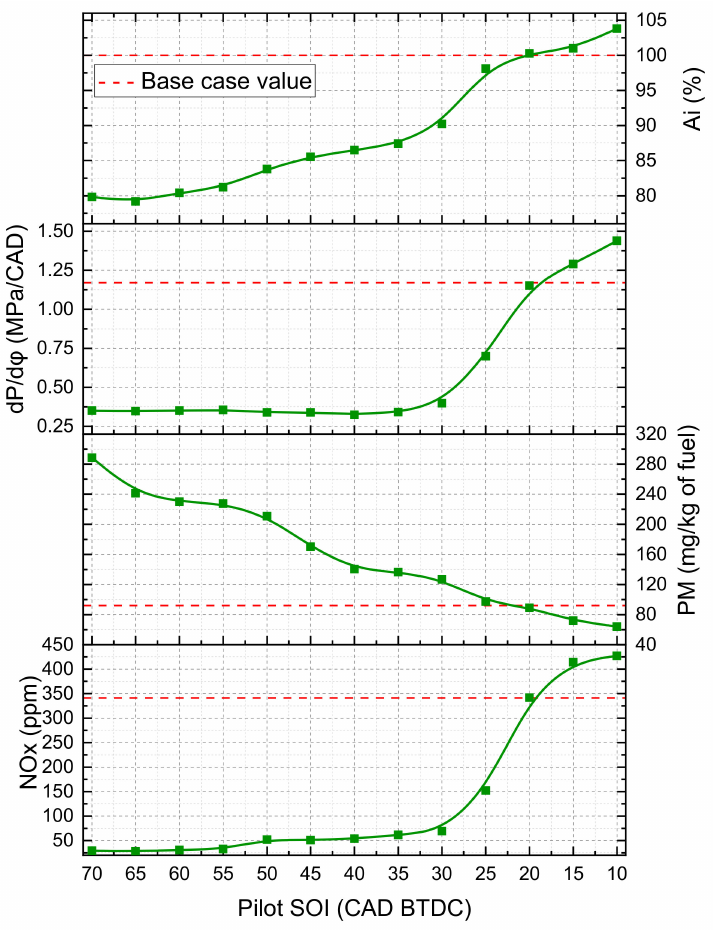
Figure 17. The pilot SOI variable influence on combustion process and emissions. The reference dashed line displays the base case level. The advancing pilot SOI decreases the indicated work. To maintain the indicated work not lower than base case level, the pilot SOI should be in the range from 20 CAD BTDC to 10 CAD BTDC. The maximum value of the pressure rise rate does not exceed the critical value of 1.5 MPa/CAD, so there is no limitation. The dependence of the pressure rise rate on the pilot SOI looks similar to that of the indicated work. The PM emission decreases with a retarding of the pilot SOI. Exceeding the base value can be seen in the range from 70 CAD BTDC to 20